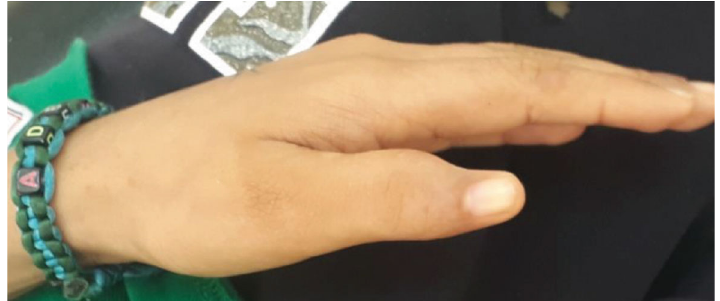
Figure 2: Operated bi fi d thumb.